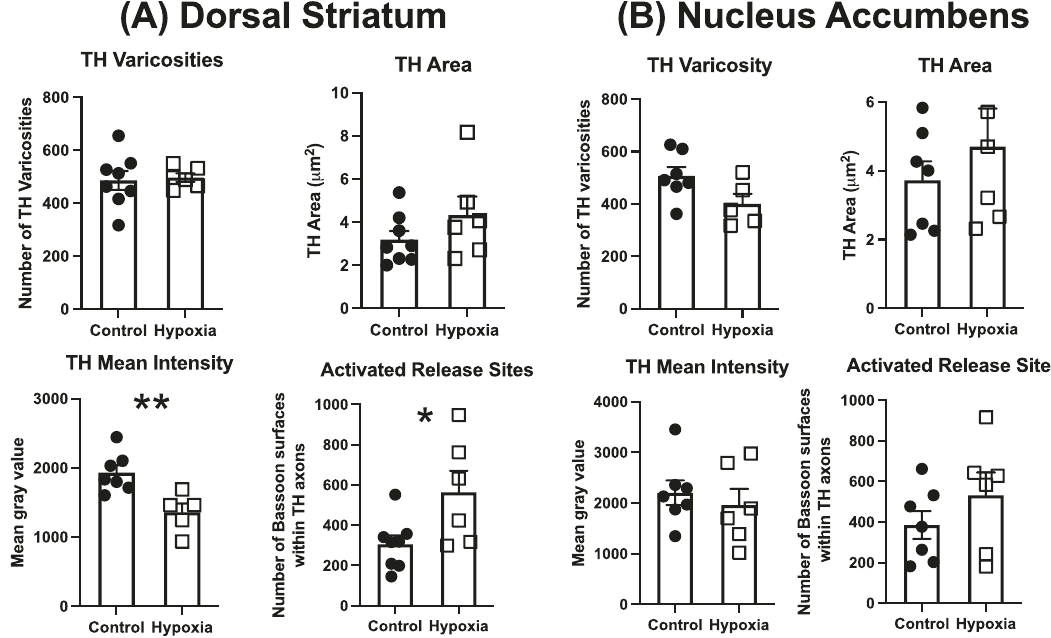
Fig. 3 Prenatal hypoxia alters DA terminal architecture in the P10 dorsal striatum. A There was no effect of prenatal hypoxia on TH varicosity number or area covered by TH varicosities in P10 dorsal striatum. Prenatal hypoxia led to a signi fi cant reduction in the intensity of TH expression and increased the number of activated release sites. B There was no effect of prenatal hypoxia on TH varicosity number, area covered by TH varicosities, intensity of TH staining or activated release site number in P10 nucleus accumbens. (Control, n = 8, hypoxia, n = 6; data are shown as mean ± SEM; Group differences are indicated by * p < 0.05, ** p <